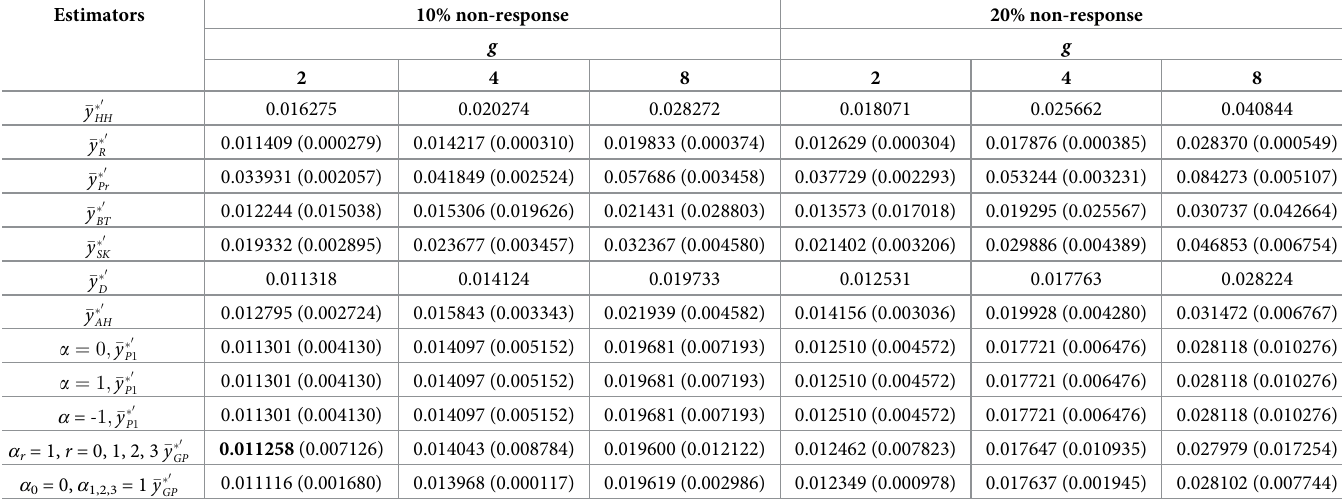
Table 9. Mean squared error and | Bias | (in brackets) values for different estimators for Population IV with measurement error.